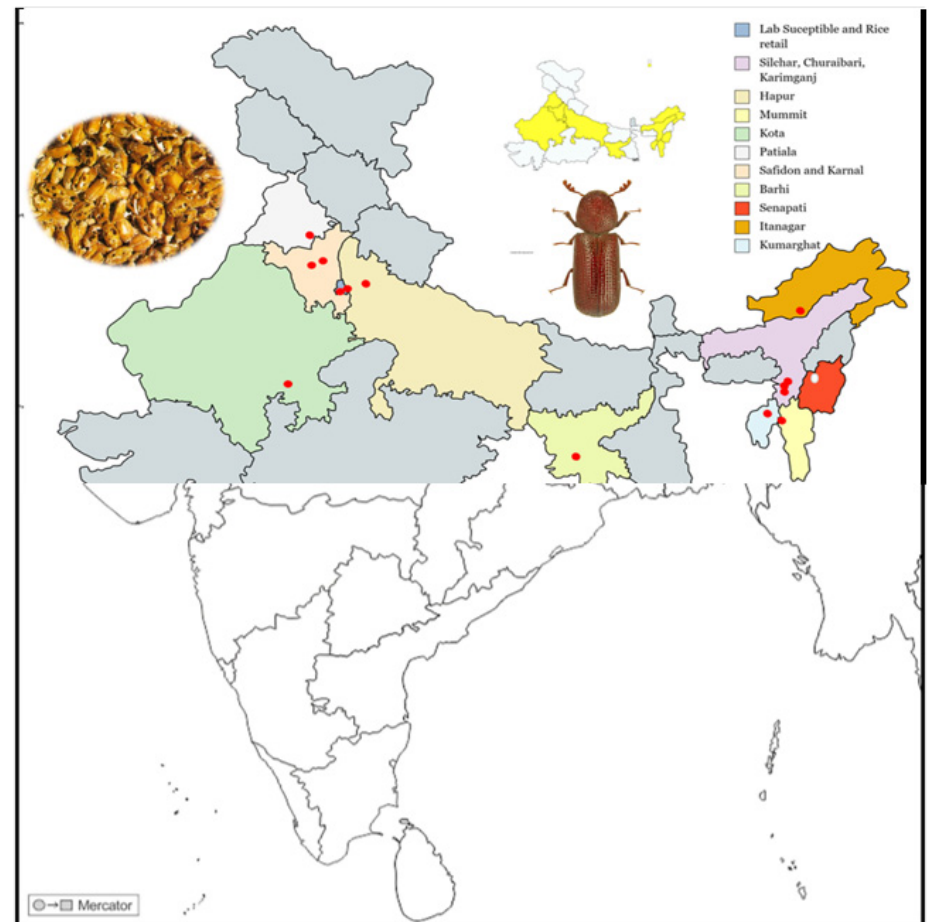
Figure 1. Locations of the Rhyzopertha dominica populations that were surveyed and collected in India. The political map of India shows different states bordered by thin lines. The geographical region of each state is marked with colors in the background. The Collection sites are marked with a red dot (•), and the location details are mentioned as legends of this figure in the top-right corner. The map was sourced from http://d-maps.com/carte.php?num_car=4183&lang=en accessed on 11 July 2022 and slightly modified in Microsoft Excel to the current frame.